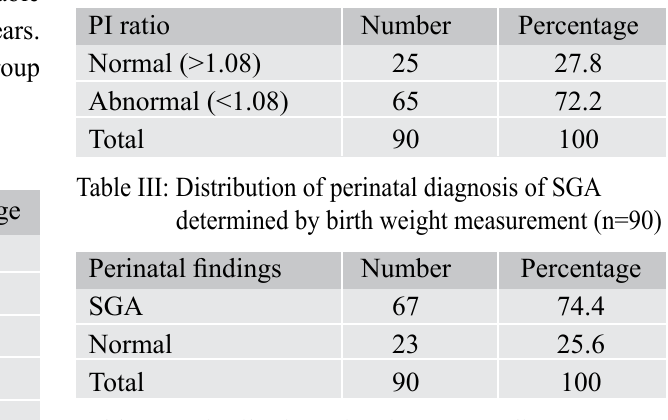
Table IV: Distribution of patients according to